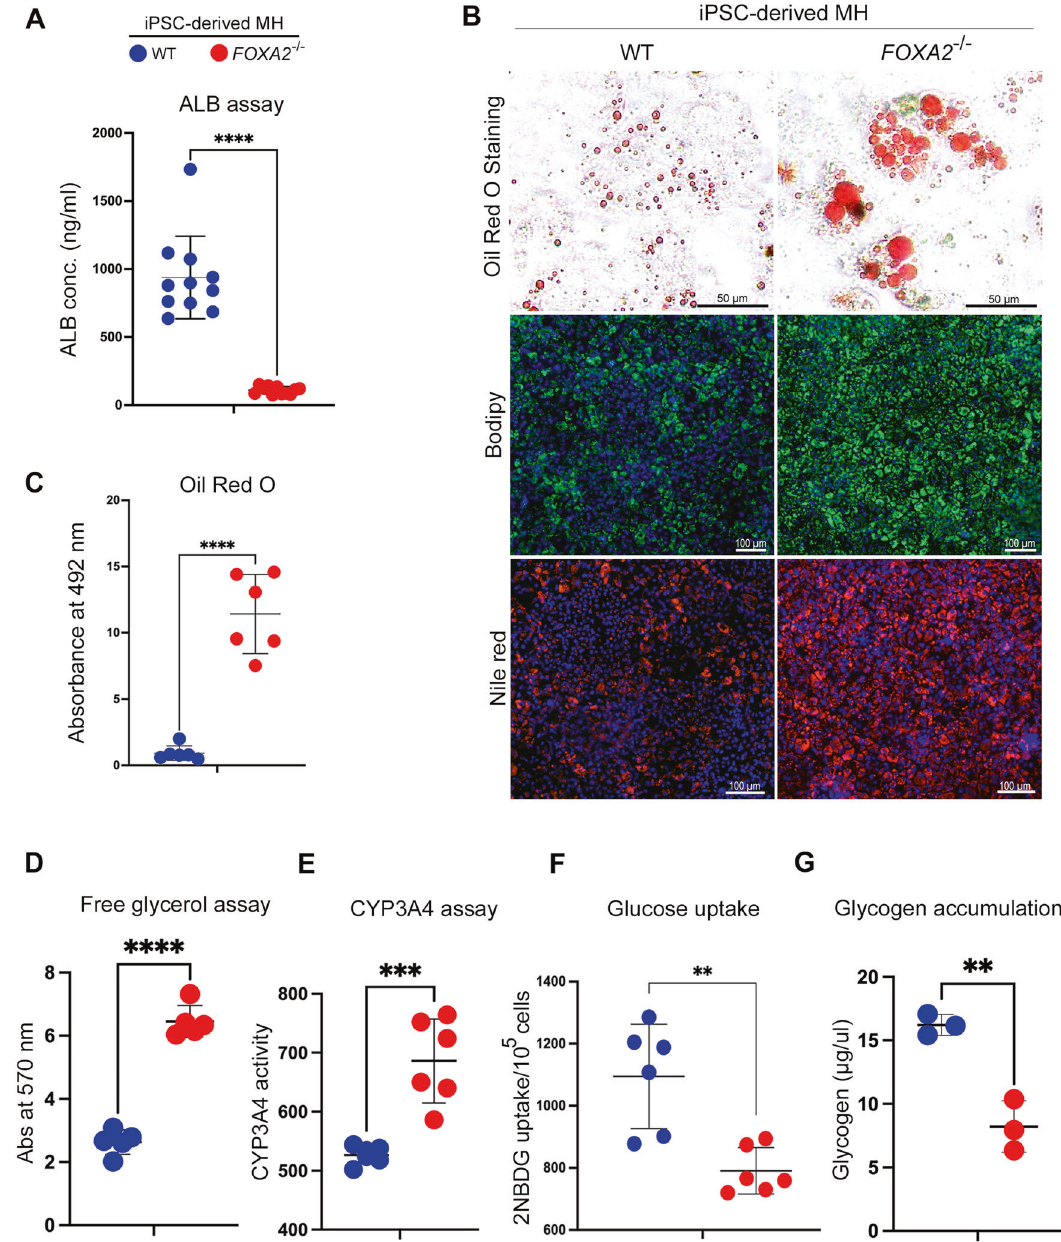
Fig. 4 Loss of FOXA2 impairs functions of iPSC-derived hepatocytes. A ELISA quanti fi cation of ALBUMIN (ALB) concertation secreted from FOXA2 − / − MH compared to WT controls ( n = 11). B Representative images showing staining of MH derived from FOXA2 − / − PSCs and WT-iPSCs with Oil Red O, BODIPY, and Nile red. C Oil Red O, free glycerol ( D ), and CYP3A4 activity ( E ) were measured in FOXA2 − / − MH compared to WT controls ( n = 6). F Relative glucose uptake in FOXA2 − / − MH relative to WT controls ( n = 6). G Relative glycogen accumulation in FOXA2 − / − MH relative to WT controls ( n = 3). Data are represented as mean ± SD; * p < 0.05, ** p < 0.01, *** p < 0.001. hepatocytes from increased lipid-mediated toxicity [11]. Intracel- (Fig. 4B). Quanti fi cation of Oil Red O staining showed a signi fi cant lular CYP3A4 protein activity levels were quanti fi ed by measuring increase in lipid accumulation in FOXA2 − / − MH compared with WT its enzyme activity. We noticed a dramatic increase in CYP3A4 controls (Fig. 4C, Supplementary Fig. 5). Effect of increased lipid levels in FOXA2 − / − MH in comparison to WT controls (Fig. 4D), accumulation on resultant lipolysis was evaluated by quantifying free glycerol, as free glycerol along with free fatty acid is a product suggesting that the absence of FOXA2 increases CYP3A4 levels to of triglyceride (TG) lipolysis. Our results showed an increase in overcome the toxicity elicited by increased lipid accumulation. glycerol levels in the absence of FOXA2 (Fig. 4C), indicating an Furthermore, the effect of FOXA2 de fi ciency on the glucose upregulation in lipolysis to alleviate the burden of increased lipid uptake potential of hepatocytes was measured, as hepatocytes accumulation. Furthermore, the effect on internal CYP3A4 activity account for one of the main tissues for insulin-mediated glucose in reaction to increased lipid accumulation was evaluated, as uptakes [12]. Our analysis showed a signi fi cant decrease in CYP3A4 is found to play a signi fi cant role in detoxifying glucose uptake in FOXA2 − / − MH, suggesting that FOXA2 plays an